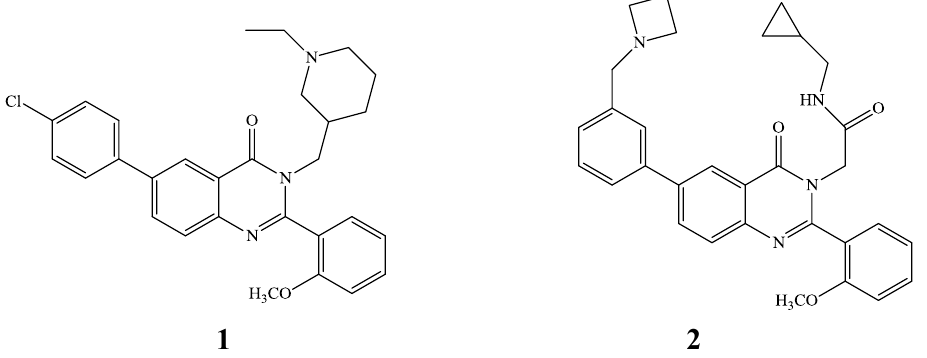
Figure 1. Examples of biologically-relevant polycarbo-substituted quinazolin-4(3 H )-ones.